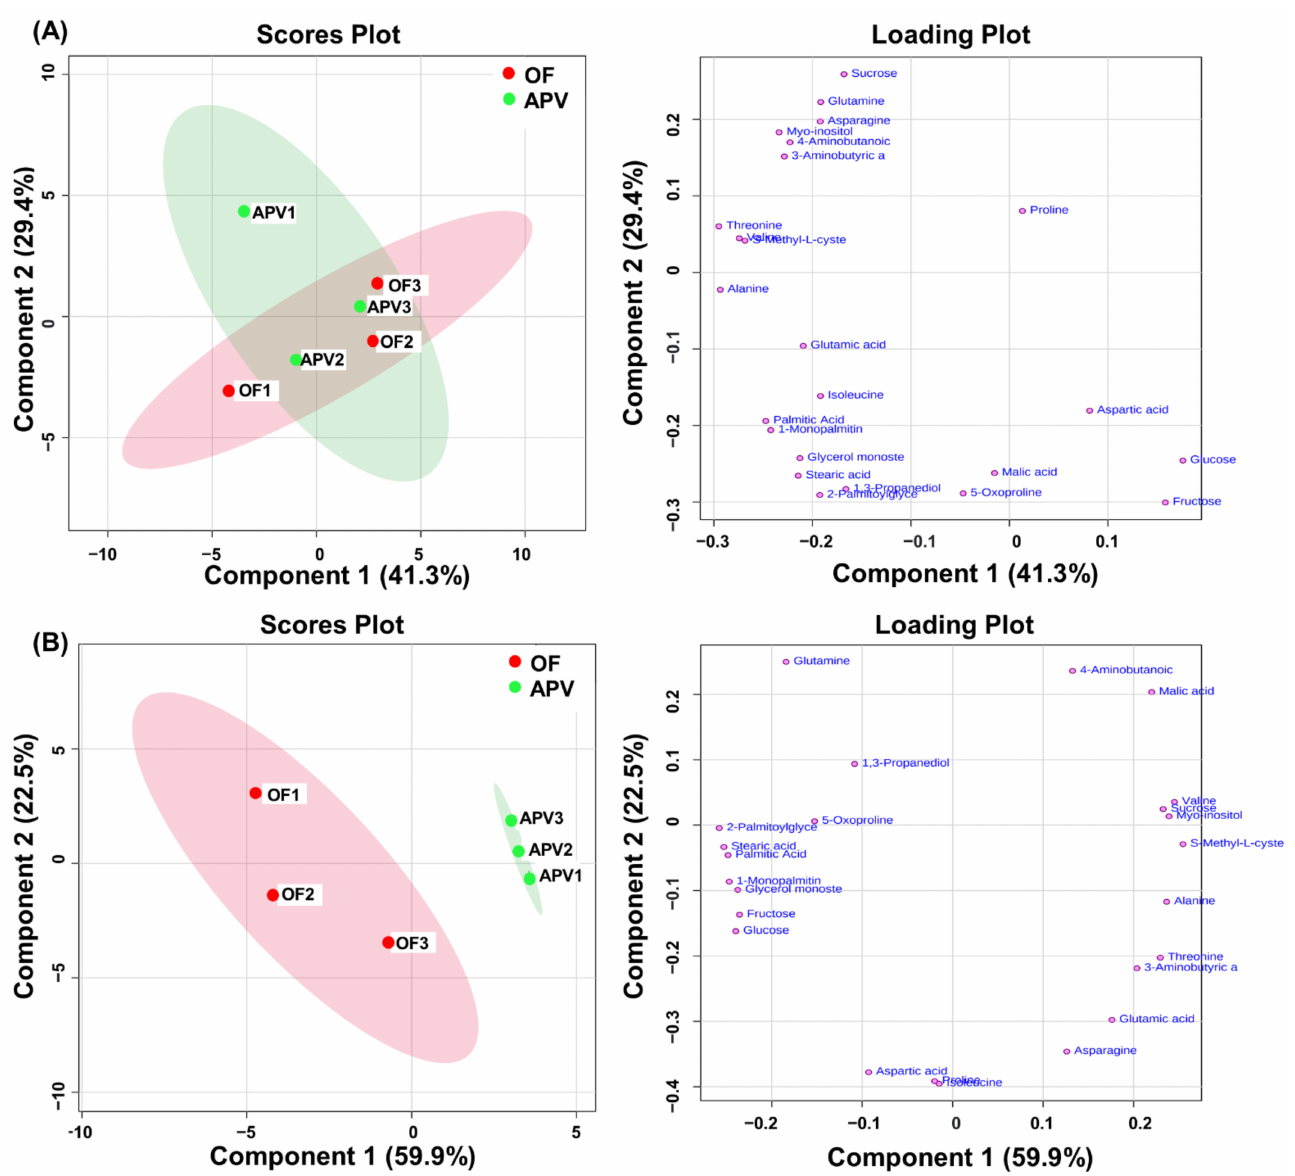
Figure 3. Scores and loading plots from principal component analysis (PCA) of fresh cabbage ( A ) and cabbage juice ( B ) from open-field and agriphotovoltaic systems. Metaboanalyst 5.0 was used for performing